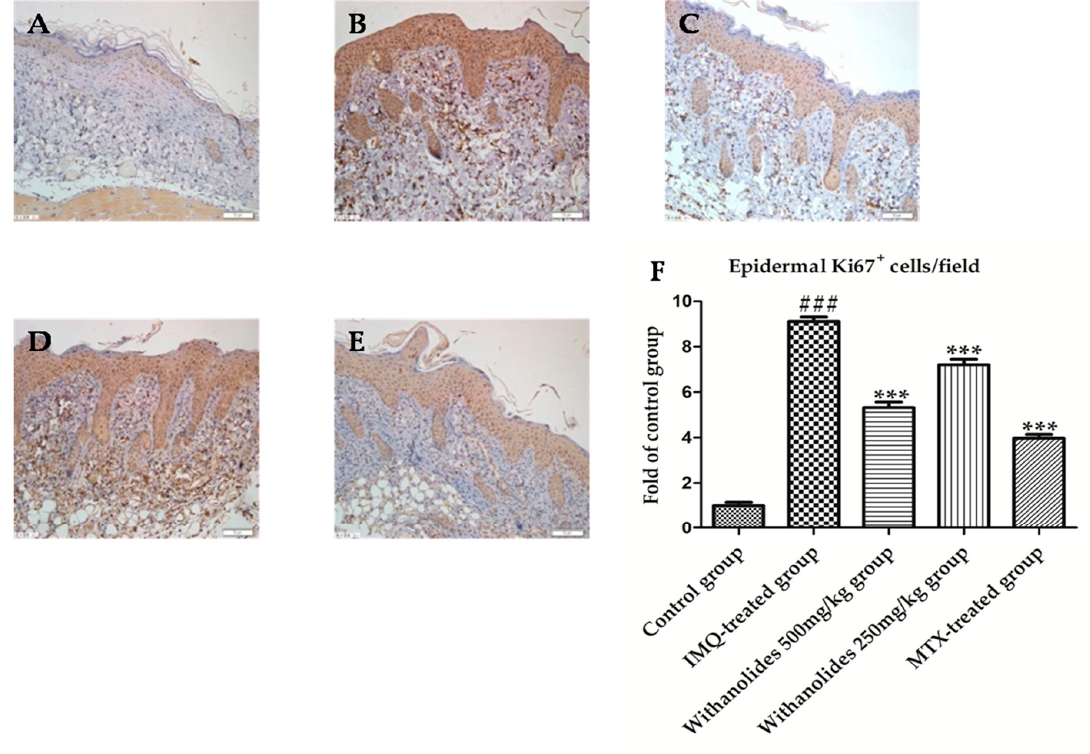
Figure 4. The psoriasis-like skin sections were strained by immunohistochemistry to evaluate Ki67 in five groups. ( A ) Control group. ( B ) IMQ-treated group. ( C ) Withanolides 500 mg / kg group. ( D ) Withanolides 250 mg / kg group. ( E ) MTX-treated group. ( F ) Ki67 positive cell / field (IF × 400). *** p < 0.001 vs. IMQ-treated group, ### p < 0.001 vs. control group.